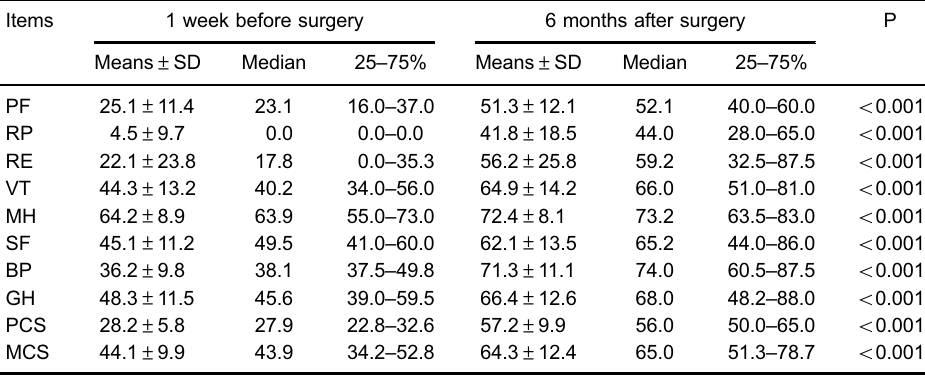
Table 2. SF-36 scores before and after surgery.